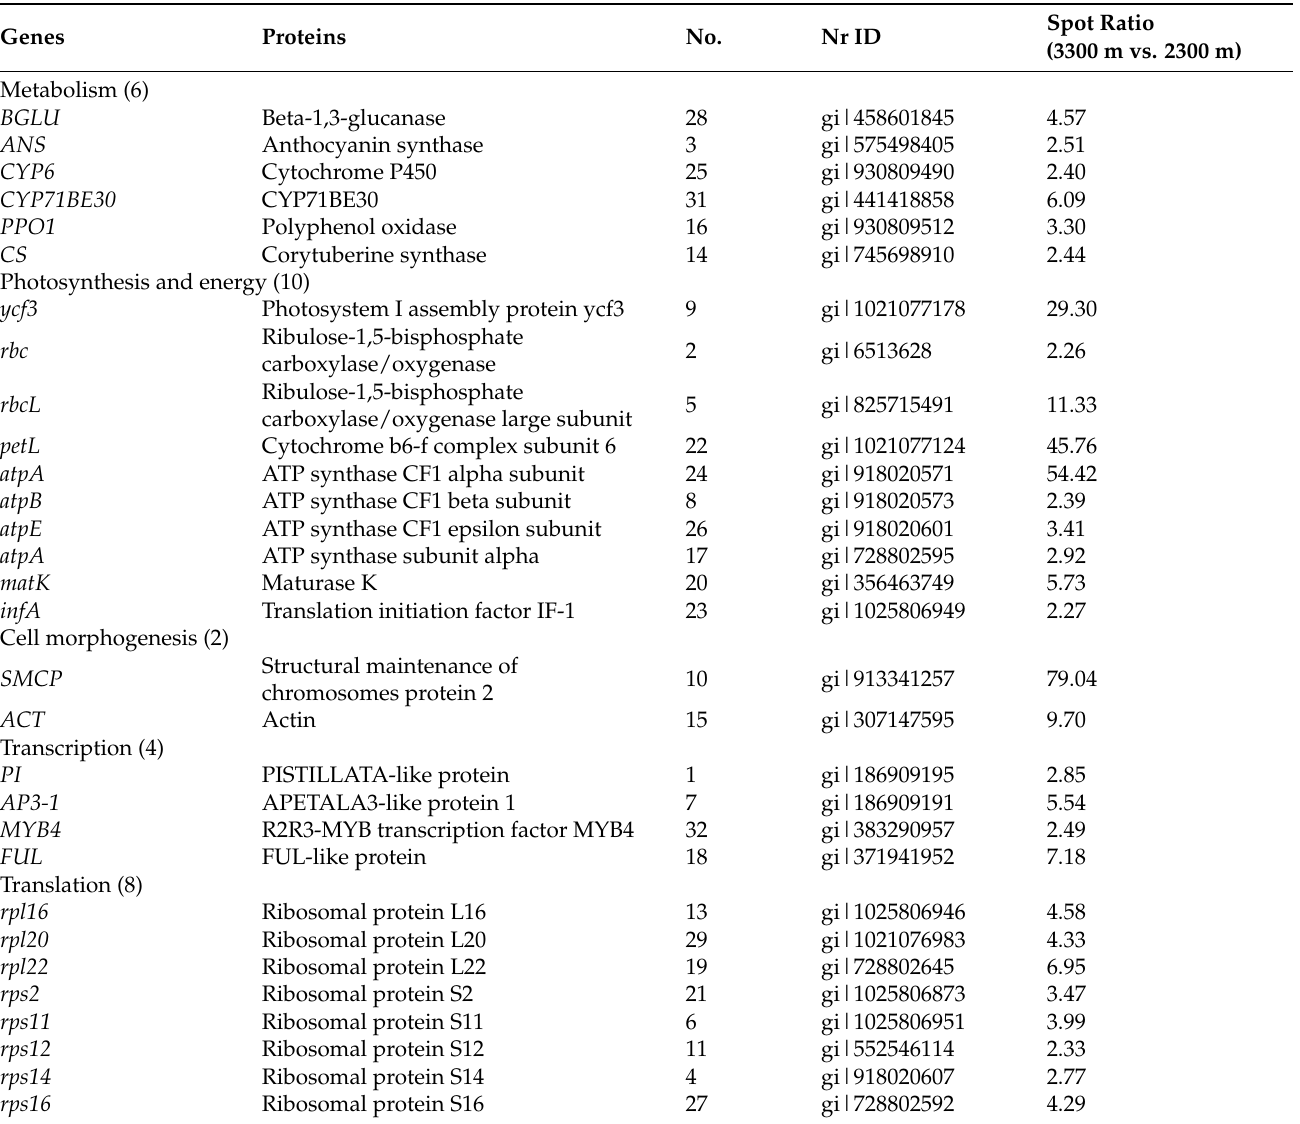
Table 1. Thirty differentially over-expressed proteins at 3300 vs. 2300 m.